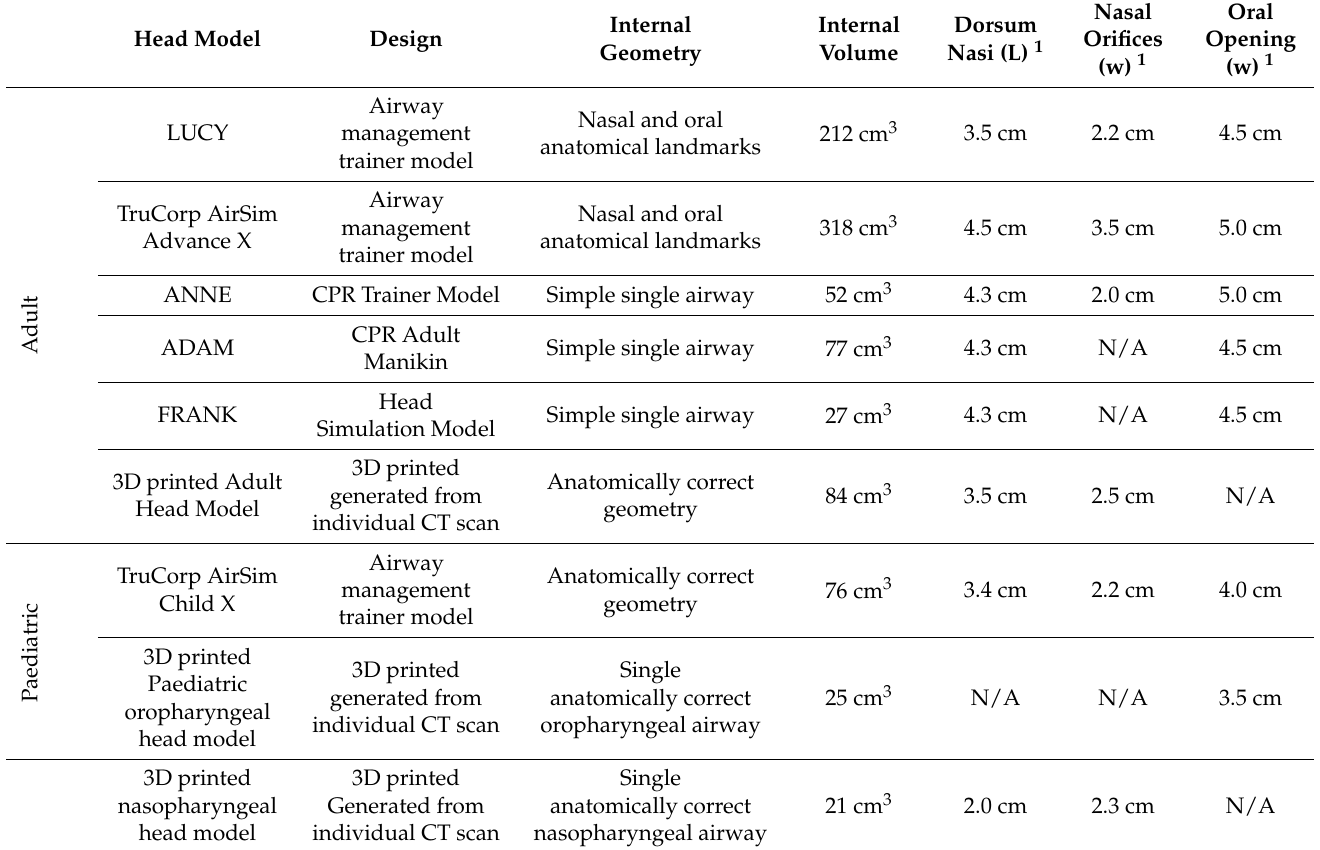
Table 1. Head Model